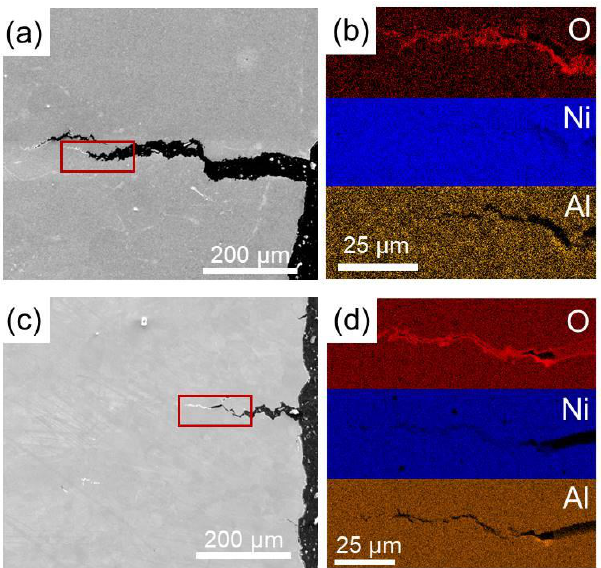
Figure 9. SE images ( a , c ) and element distribution maps ( b , d ), of the cross-sections for SL ( a , b ) and SH ( c , d ).